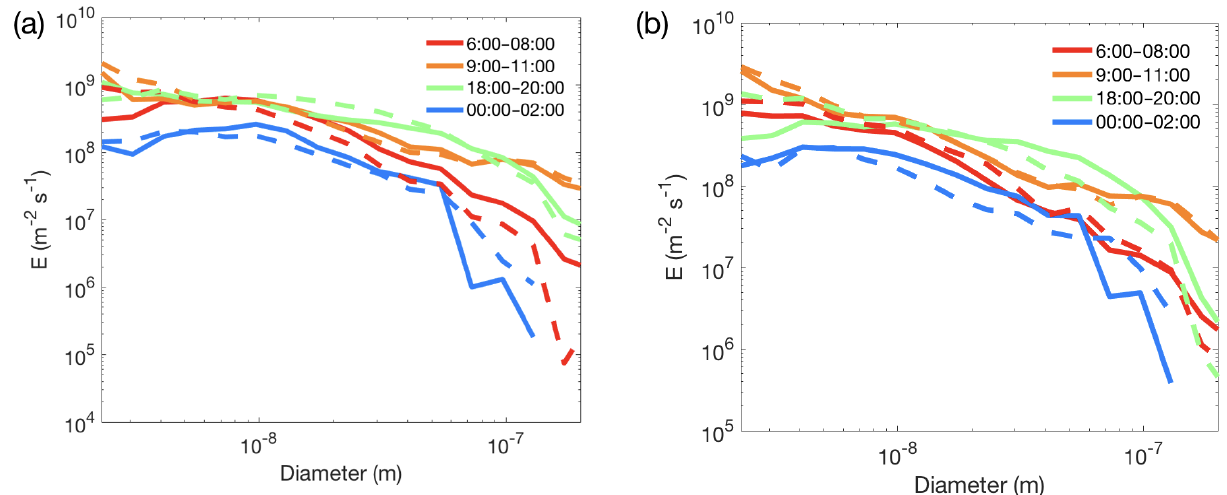
Figure A5. Average particle number emission size distributions for non-NPF event days (a) when wind is coming from the southeastern directions (45–225 ◦ ; solid lines) and from the northwestern directions (225–45 ◦ ; dashed lines) and (b) when wind speed is predominantly below 0.6ms − 1 (solid lines) and over 1.1ms − 1 (dashed lines).